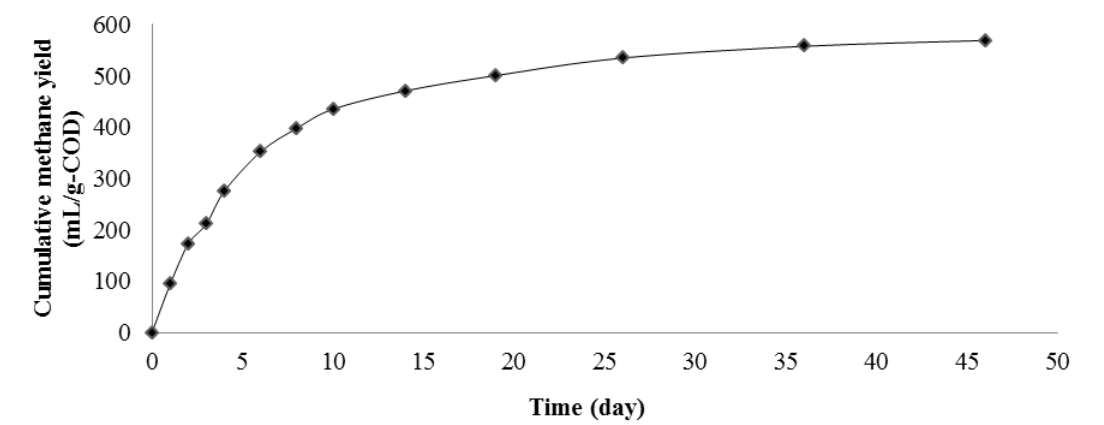
Figure 4 . Cumulative methane yield of PME at substrate concentration of 5 g-COD/L and